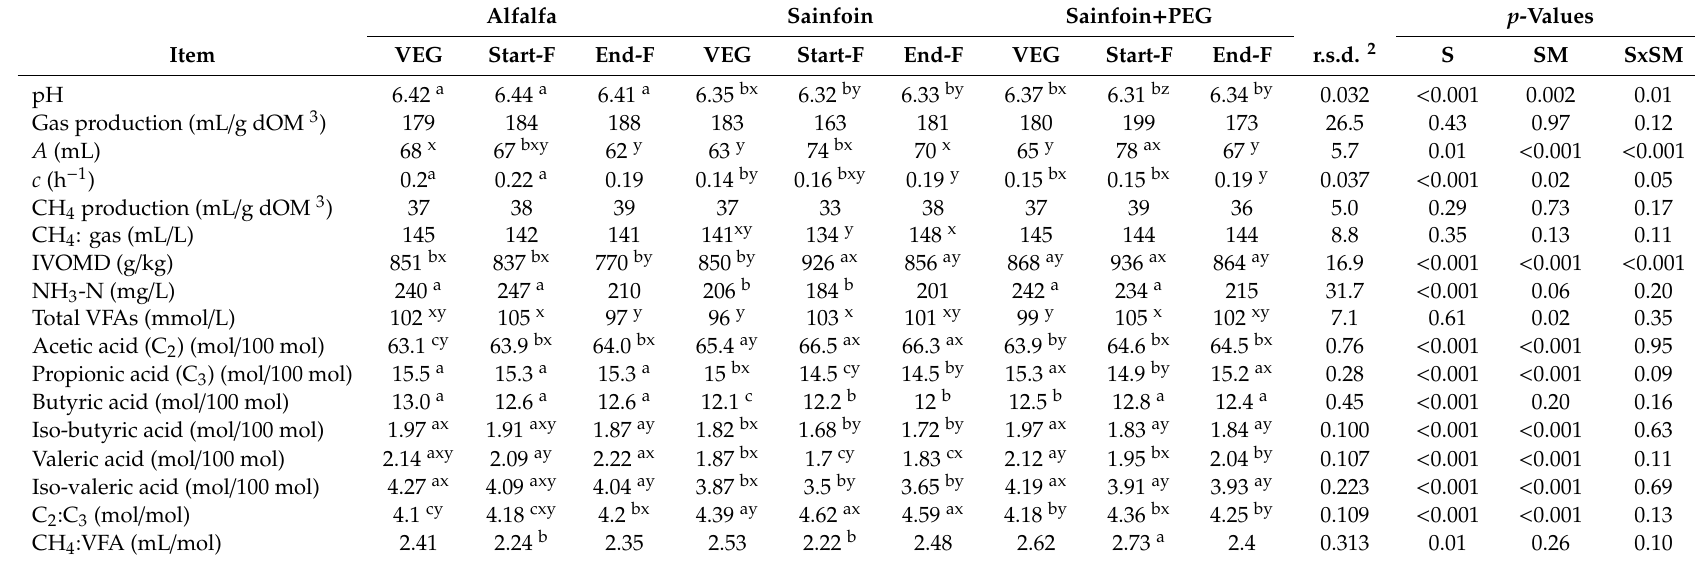
Table 2. E ff ect of the substrate (S) and the stage of maturity 1 (SM) on gas and methane production (CH 4 ), potential gas production ( A ), rate of gas production ( c ), in vitro organic matter degradability (IVOMD), ammonia (NH 3 -N), and volatile fatty acids